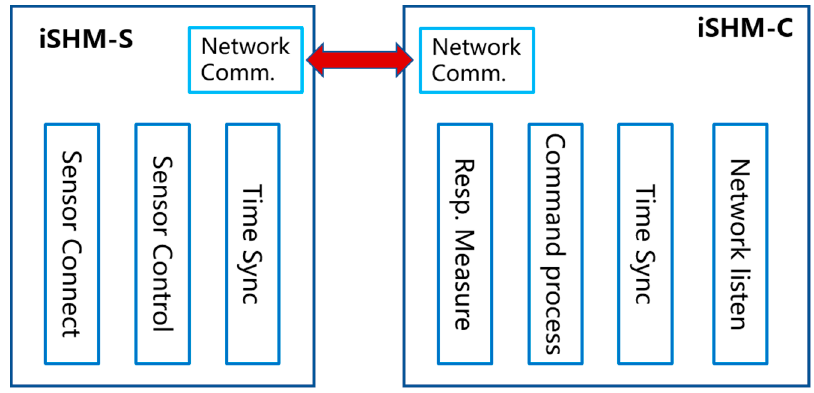
Figure 2. Functional modules of iSHM-S and iSHM-C.